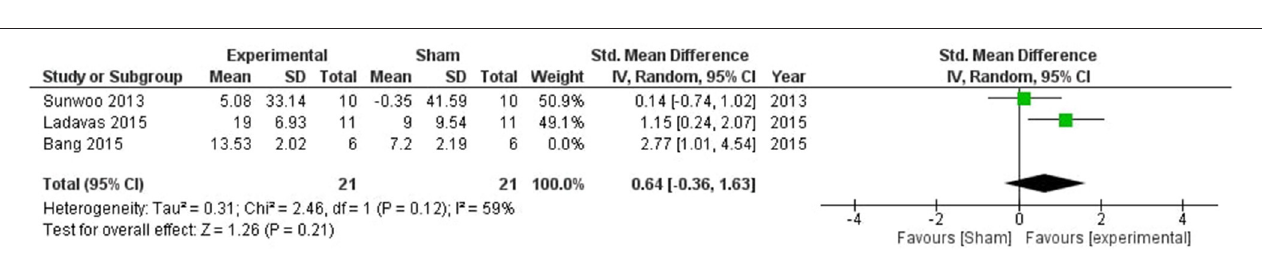
FIGURE 5 | Comparison of the effects of active transcranial stimulation and sham stimulation interventions on aphasia. Two studies were excluded after sensitivity analysis. The results indicated that real stimulation is significantly better than sham stimulation in facilitating the verbal learning (SMD = 0.34; 95% CI = 0.02–0.67; p = 0.04).